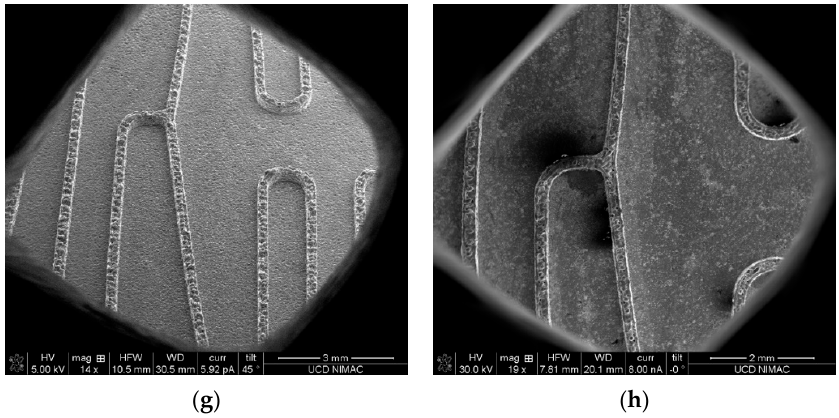
Figure 7. Comparison of tool finish before and after electropolishing: ( a ), ( c ), ( e ) and ( g ) are unpolished features and ( b ), ( d ), ( f ) and ( h ) are the corresponding polished features (note: scale bar for ( c ) and ( d ) are 500 and 400 µm, scale bar for ( g ) and ( h ) are 3 and 2 mm).